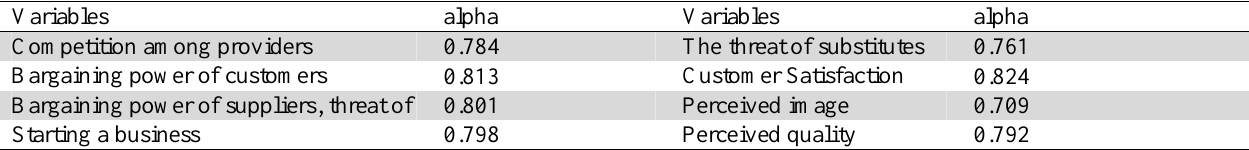
Questioner Alfa